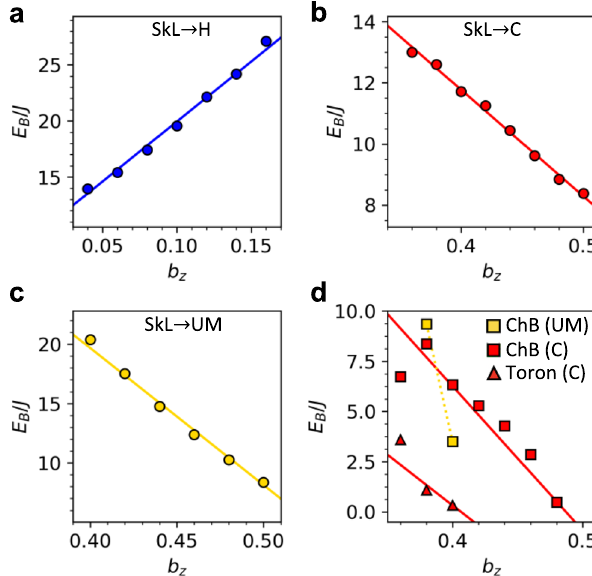
Fig. 6 Field dependence of the annihilation energy barriers. a – c The fi eld dependence of the simulated energy barrier which must be overcome to form one pair of Bloch points is plotted as a function of the applied fi eld for the skyrmion lattice to helical (SkL → H) (blue), skyrmion lattice to conical (SkL → C) (red) and skyrmion lattice to uniformly magnetised (SkL → UM) (yellow) simulations. d The simulated energy barrier for the annihilation of a chiral bobber (ChB, squares) or a toron (triangles) is plotted as a function of the applied magnetic fi eld for the SkL → C (red) and SkL → UM (yellow) decay mechanisms. Each dataset has been fi tted with a linear